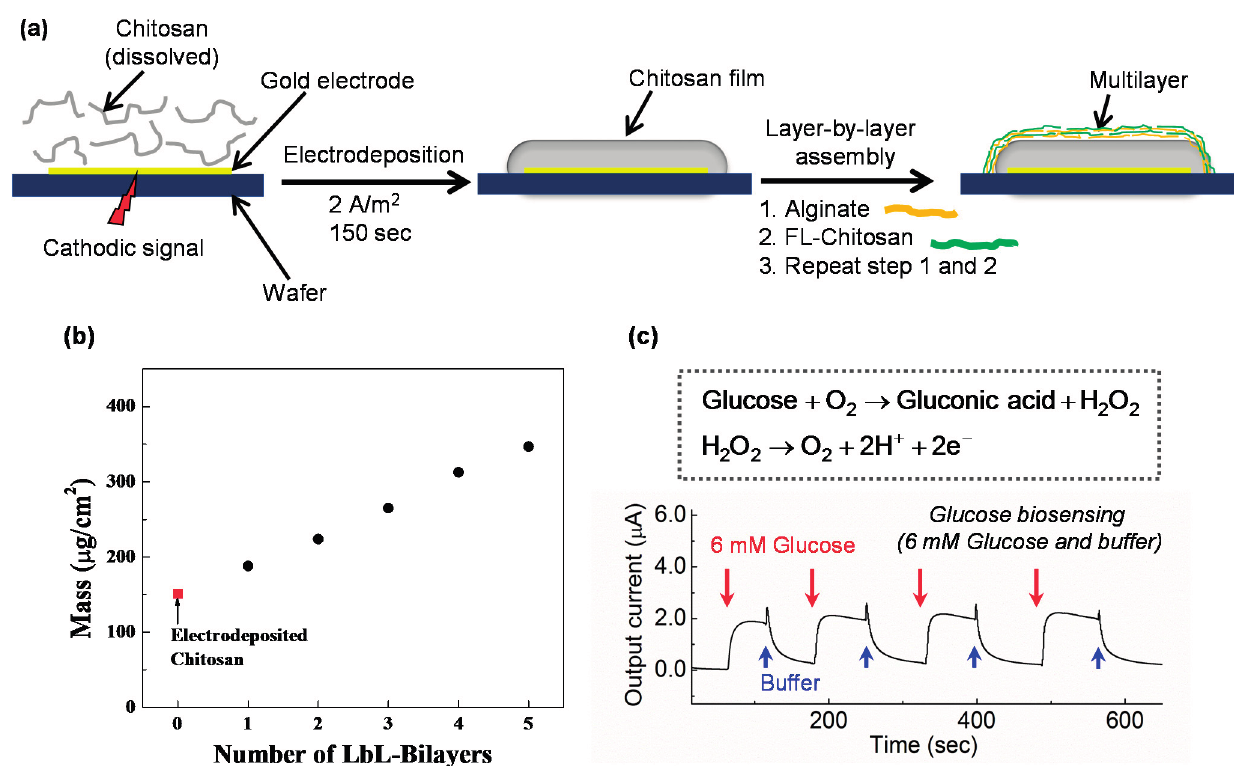
Figure 10. Coupling chitosan’s electrodeposition with layer-by-layer assembly of chitosan-alginate multilayers. ( a ) Schematic of assembly steps; ( b ) Quartz crystal microbalance with dissipation (QCM-D) measurments showing controlled assembly of multilayer film; ( c ) Assembly of model enzyme glucose oxidase (GOx) confers biosensing function to the assembled multilayer. Reproduced with permission from [125], published by John Wiley and Sons,